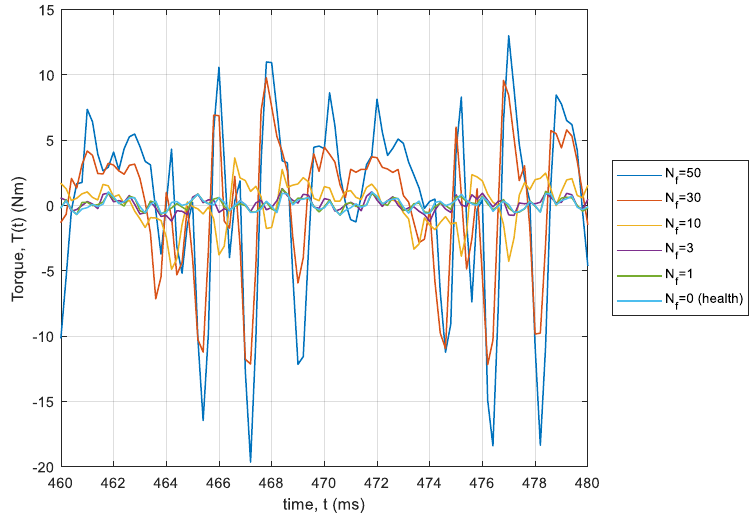
Figure 9. Torque waveforms at steady state (time: 460–480 ms) and T L = 0 Nm.